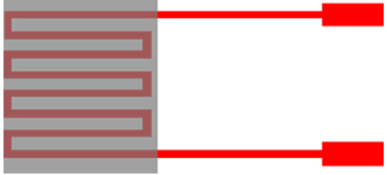
Figure 2. Schematic diagram of resistive micro humidity sensor.